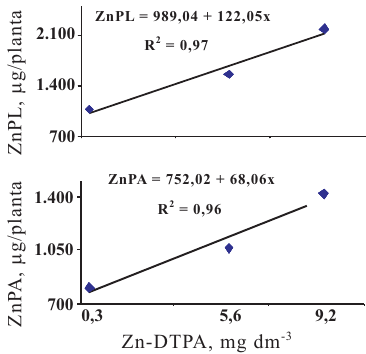
Figura 2. Conteúdo de zinco na planta inteira (Zn–PL) ou na parte aérea (Zn–PA) em função do teor disponível no solo pelo extrator Mehlich-1, na espécie C. arabica